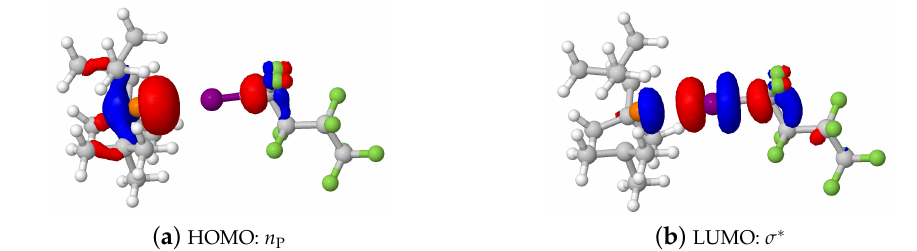
Figure 4. Frontier molecular orbitals of the t Bu 3 P-IC 4 F 9 adduct at the S 0